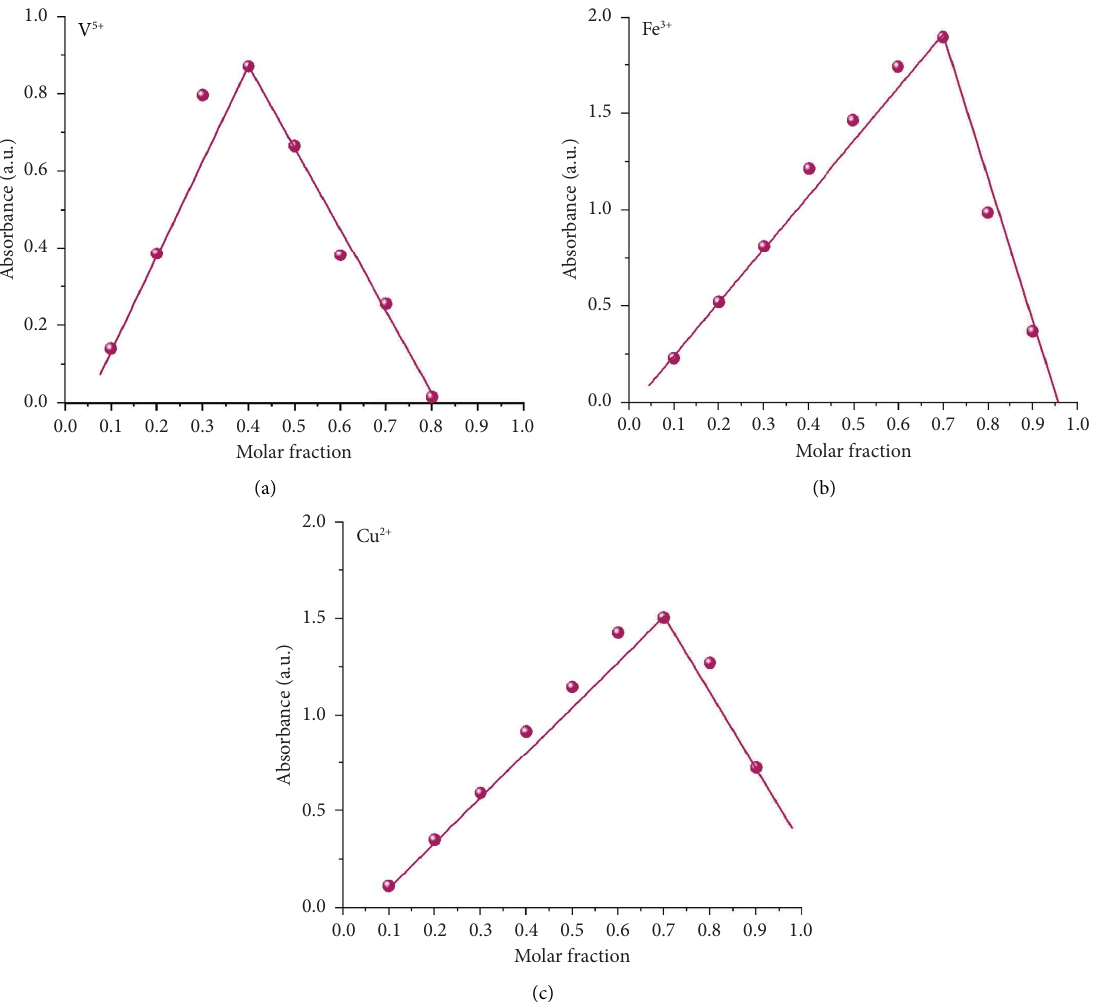
Figure 3: Job’s plot for SL at wavelengths 456, 461, and 465nm with Cu 2+ , Fe 3+ , and V 5+ , respectively, by UV–vis.